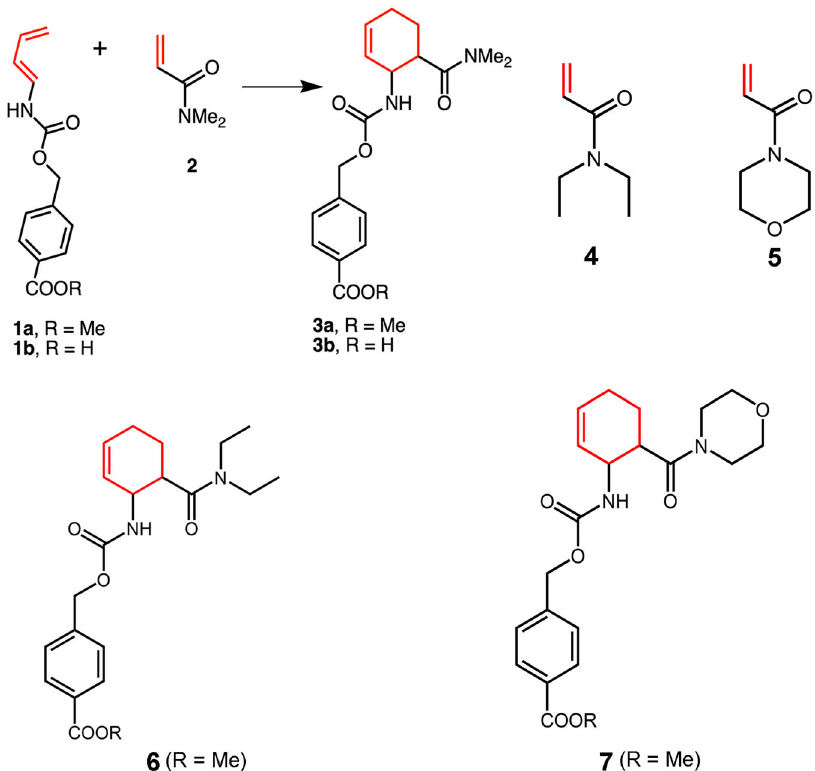
Fig. 1 Scheme and chemical diagrams of molecules used in this study. Representative Diels – Alder reaction between 4-carboxybenzyl-trans-1, 3-butadiene- 1-carbamate ( 1 ) and N , N -dimethylacrylamide ( 2 ) to yield product ( 3 ). Chemical diagrams of other compounds used in the study are also shown